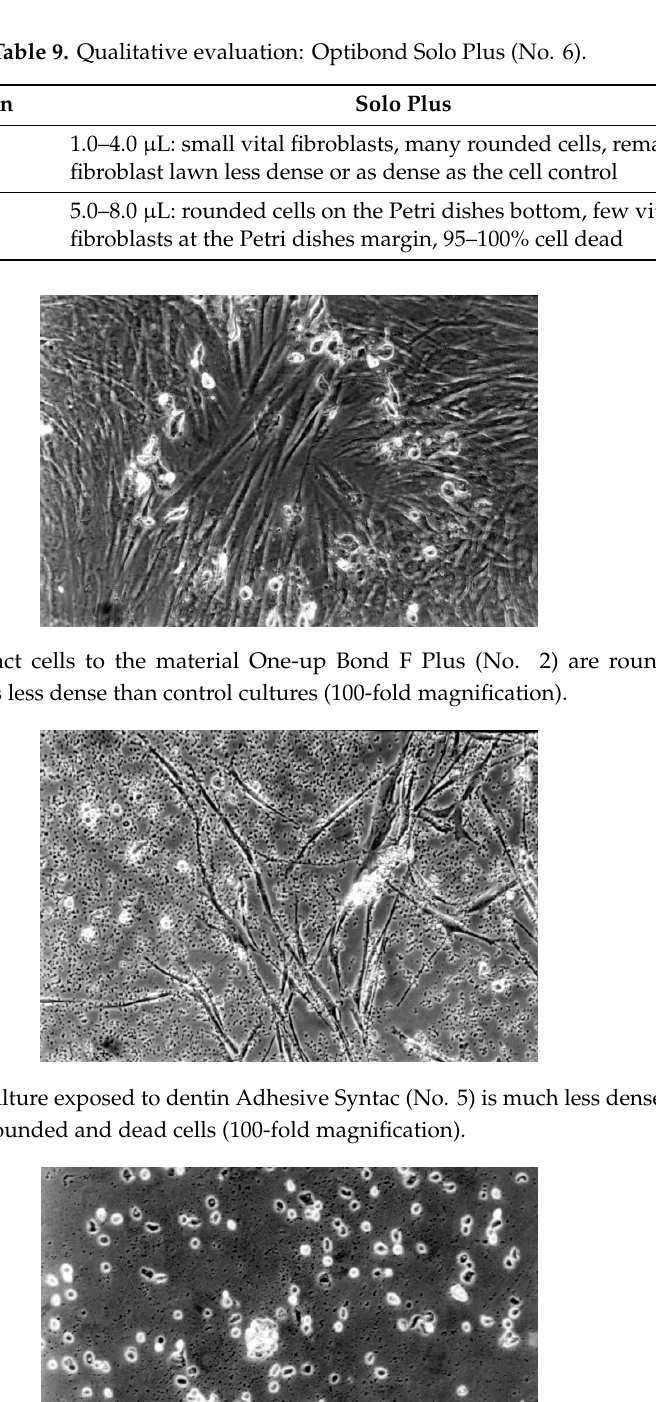
Table 10. Mean, standard deviation (sd), minimum (Min.), maximum (Max.) and median values of reactivity index.